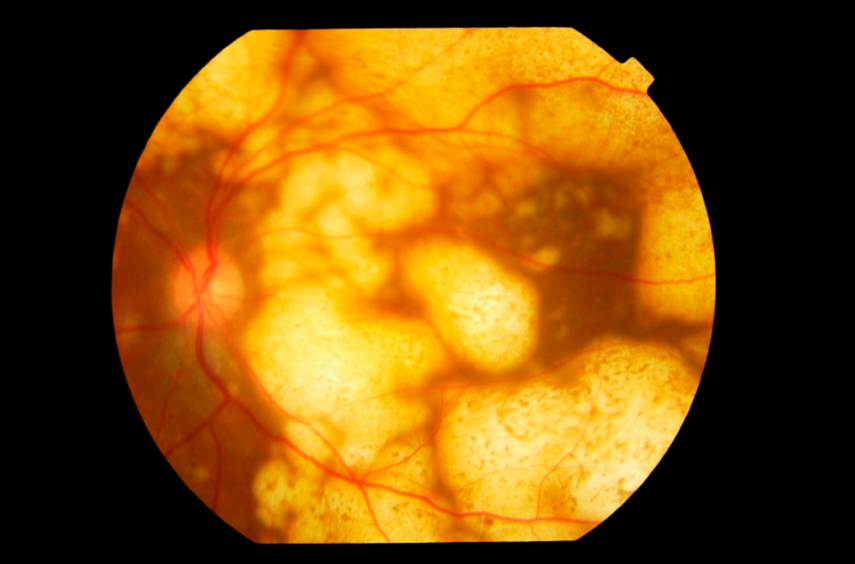
Figure 4. Fundus photograph of the left eye showing extensive involvement of the entire fundus by multiple nodular subretinal lymphoma masses of varying sizes. The larger peripheral lesions are formed by the merging of small lesions and have pigmentary change, giving a “leopard spot” appearance. The multiple yellow creamy lesions superior temporal to the disc which are smaller and more recent are also subretinal in